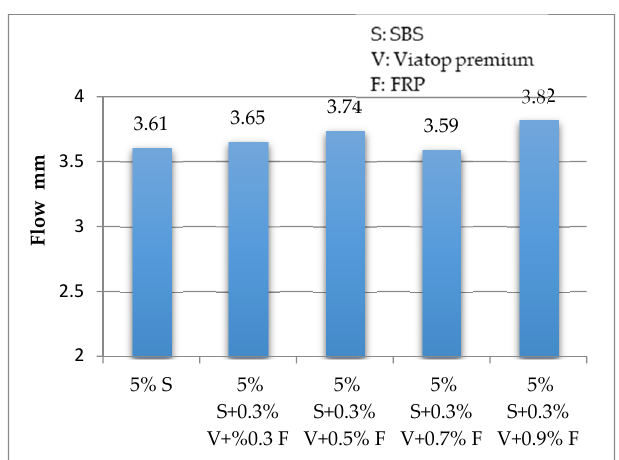
Figure 2. Results of Marshall Flow test.